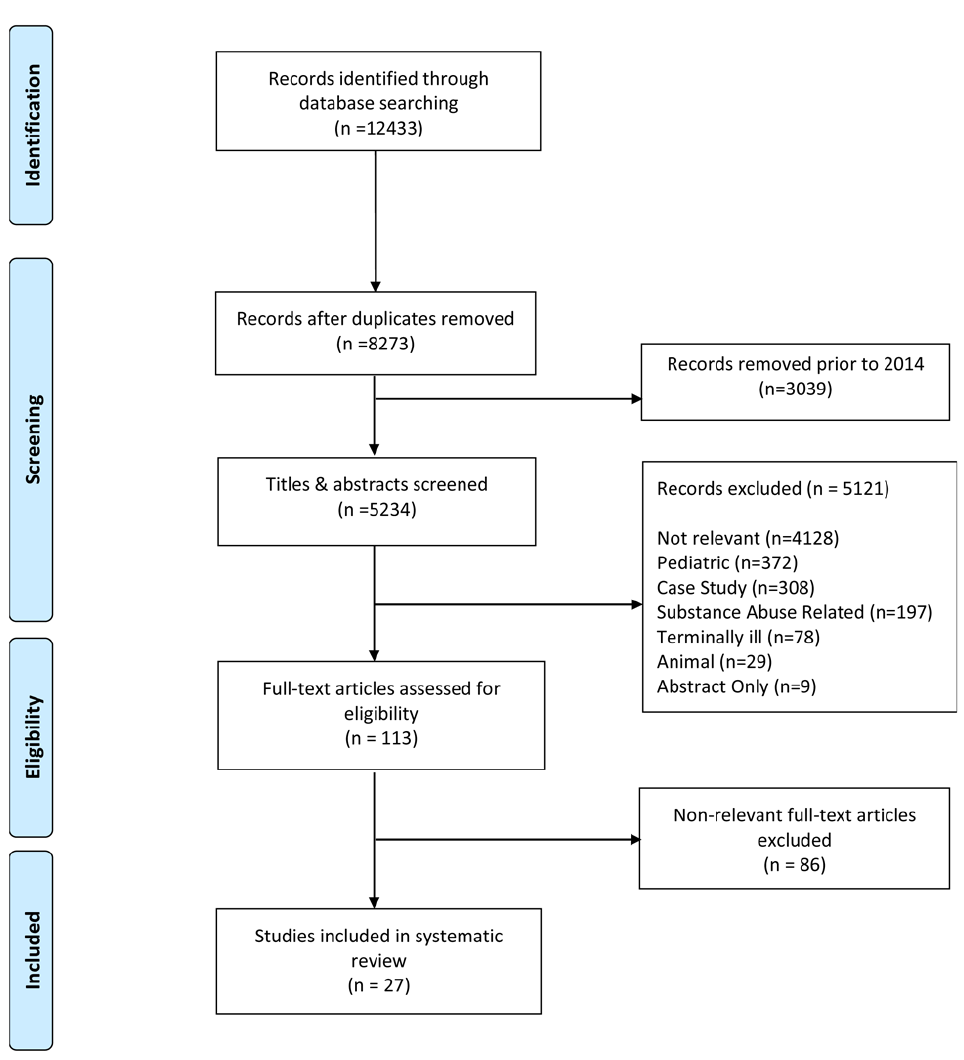
Figure 1. PRISMA Record Screening Flow